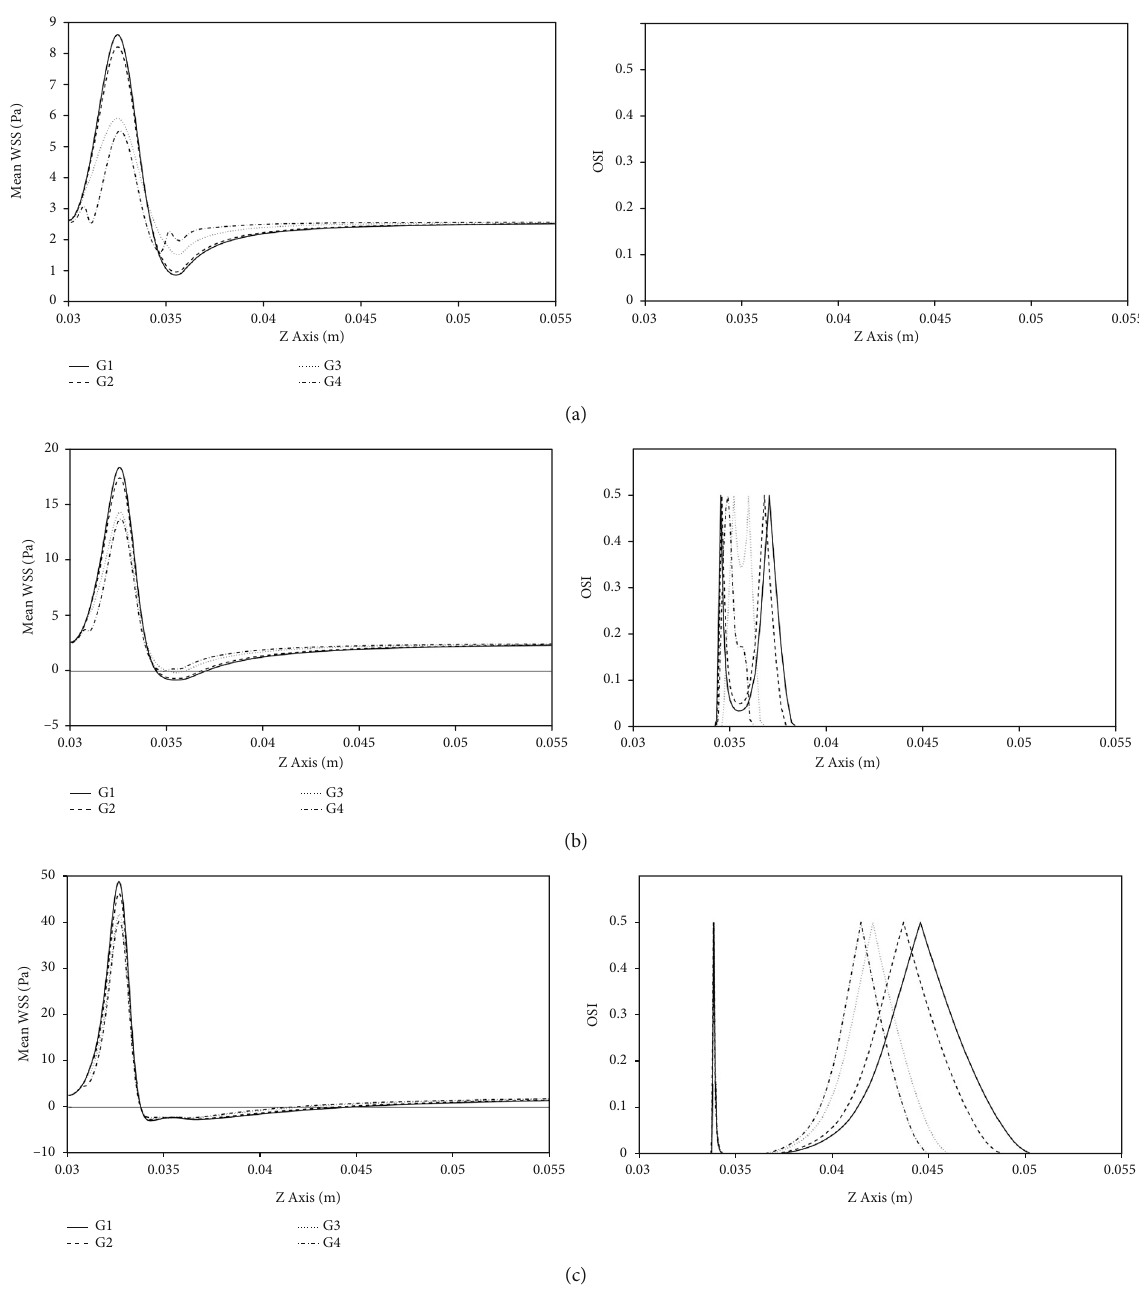
Figure 6: Mean WSS and OSI for (a) 30% stenosis, (b) 50% stenosis, and (c) 70% stenosis. Table 4: Mean length of reversal fl ow